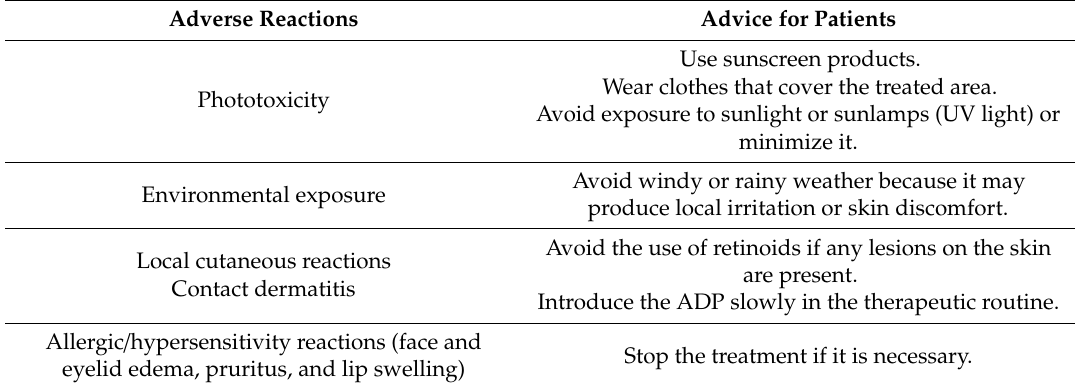
Table 4. Adverse reactions during the treatment to topical gel with adapalene (ADP) (0.1%; 0.3%)